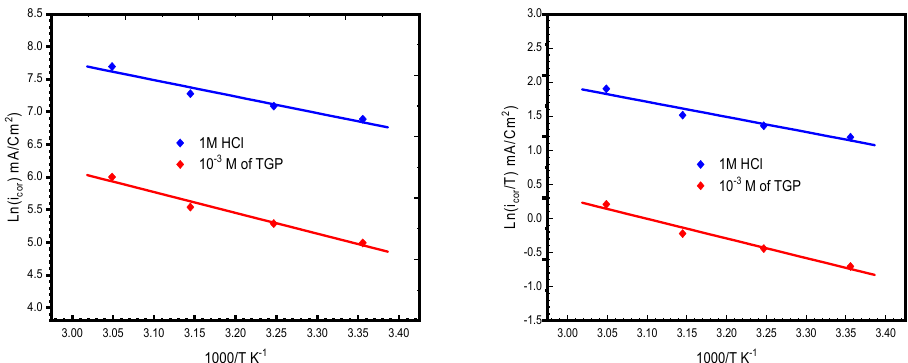
Figure 10. Ln(i corr ) as function of 1000/T ( left ) and Ln(i corr /T) as function of 1000/T ( right ) curves for MS in 1M HCl solution,both unprotected and protected by 10 − 3 M of TGP.